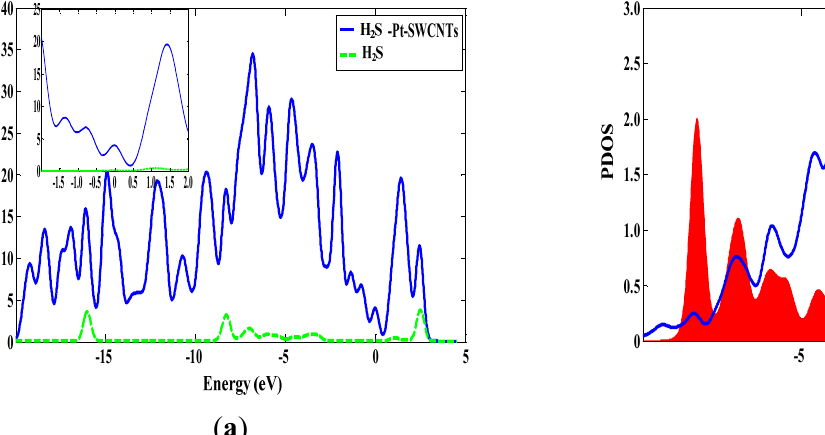
S-Pt-SWCNTs and 2 2